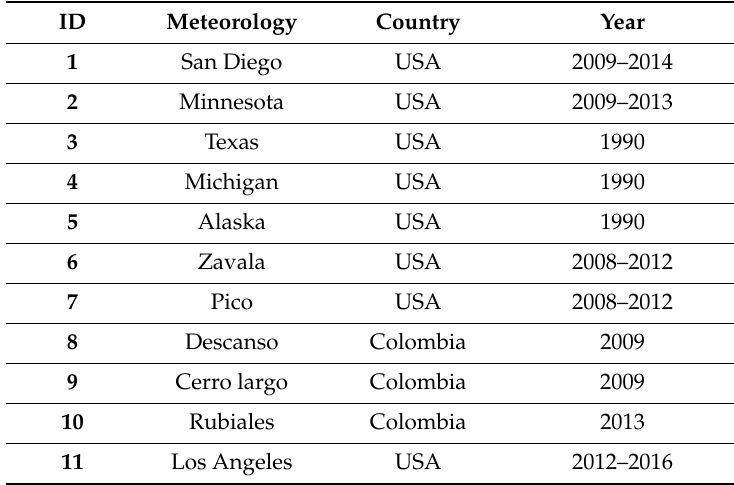
Table 2. Datasets of 1-h meteorological data used to study the dispersion of the pollutants generated during agricultural burnings. ID Meteorology